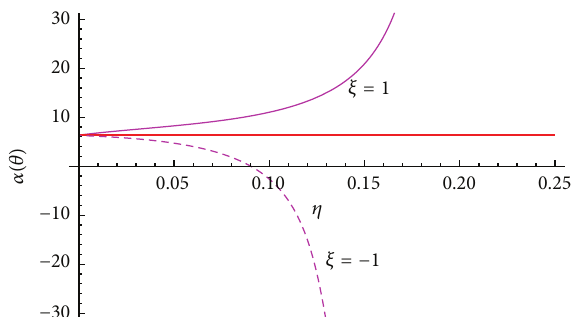
Figure 5: Deflection angle 𝛼 for ordinary and phantom global + 0.003 as a function of 𝜂 , whereas monopoles evaluated at 𝑢 = 𝑢 ps the red line indicates Schwarzschild